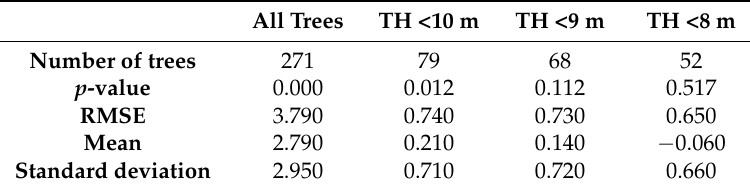
Figure 18. Probability density distributions for standardized average DBH and TH differences.TH distributions are shown for three subsets: trees with TH in the TLS dataset smaller than 10, 9, and 8 m. Vertical lines represent the standardized average values of the population. Table 3. RMSE, mean, and standard deviation (m) of the differences in TH between TLS and WLS data and p -values (H0: average TH differences are 0) for all the trees at test sites A and B, as well as for three data subsets: trees with TH estimated from the TLS dataset smaller than 10, 9, and 8 m. All Trees TH <10 m TH <9 m TH <8